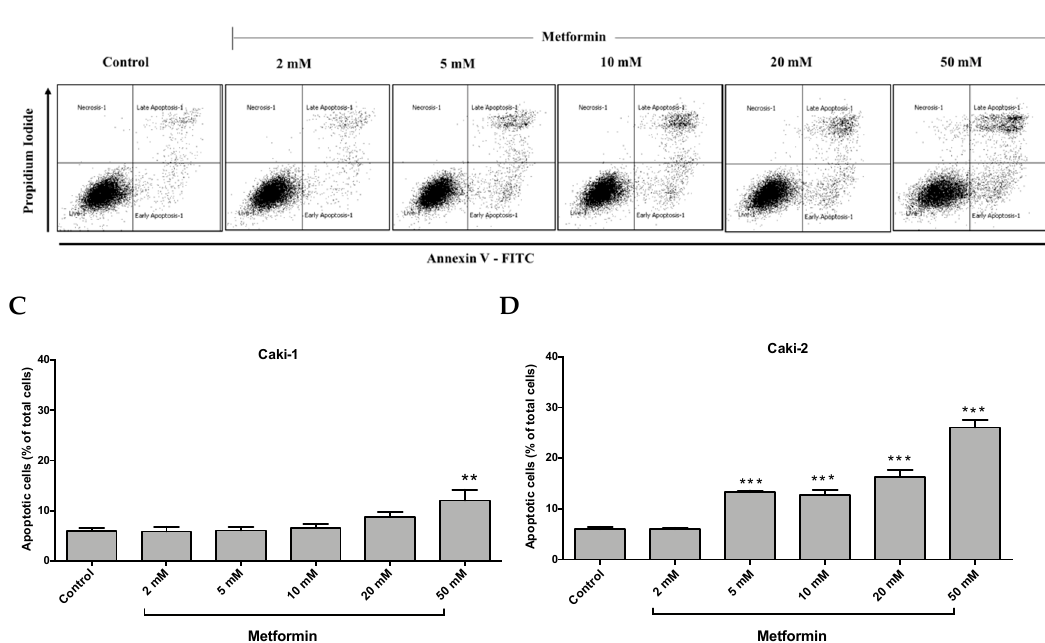
Figure 3. Metformin selectively induced a stronger apoptotic response in Caki-2 cells compared to Caki-1 cells. Flow cytometry analysis of apoptosis in ( A , C ) Caki-1 and ( B , D ) Caki-2. Cells were incubated in the absence (control) or presence of metformin (1, 2, 5, 10, 20, and 50 mM) for 48 h, and then apoptosis was determined by double labeling of cells with annexin V-FITC/propidium iodide staining, followed by flow cytometry analysis. ( C , D ) Histograms represent pooled data from four independent experiments per group. Data are presented as mean ± SEM. * P < 0.05; ** P < 0.001; and *** P < 0.0001 vs. control.